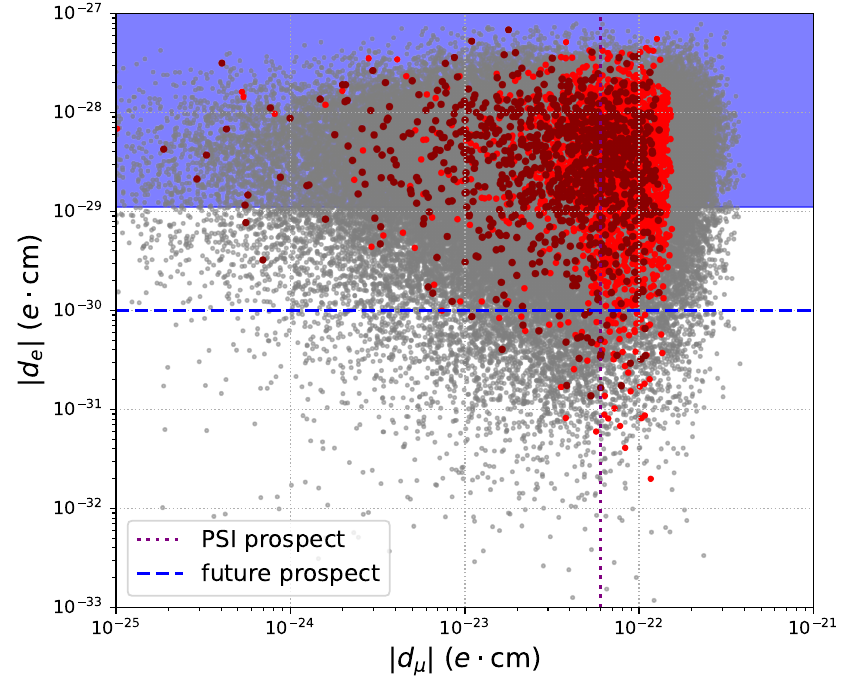
Figure 5 . The correlations between the muon and electron EDMs. The gray dots show the points excluded by the h → µ + µ − constraint. The (dark) red dots represent the points satisfying the (1 σ ) 2 σ region of the muon g − 2 . The blue band is the constraint from the ACME experiment for the electron EDM measurement. The prospect of the PSI experiment for the muon EDM measurement and the near-future electrom EDM experiments are shown as the vertical dotted line and horizontal dashed line,